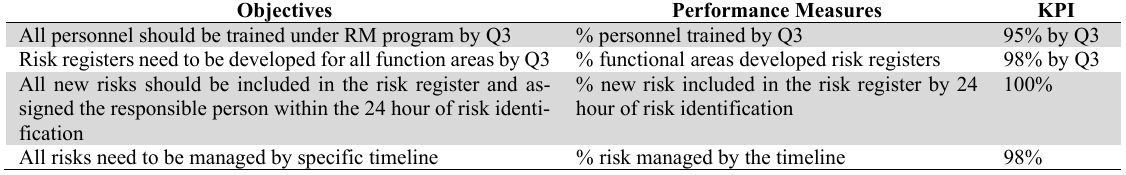
KPI for RM performance measurement Objectives Performance Measures